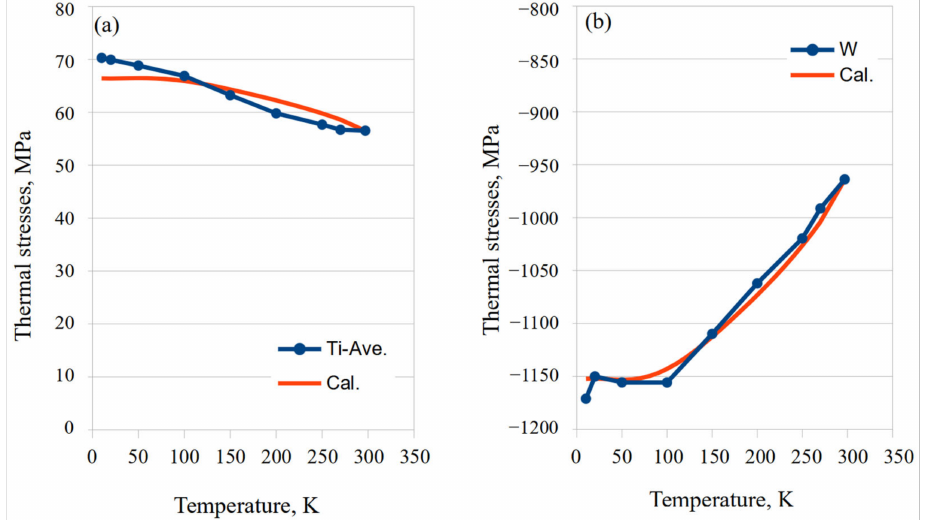
Figure 11. Comparison of calculated results from Equation (2) and measurement results in the longitudinal fiber direction: ( a ) results of the titanium matrix; ( b ) results of the tungsten